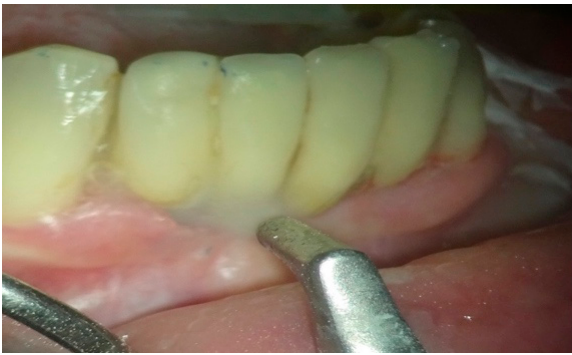
Figure 2. Airflow with erythritol, a low-abrasive powder .